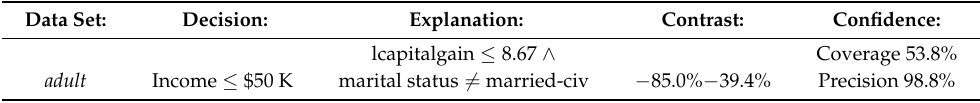
Table 1. An example of gbt-HIPS